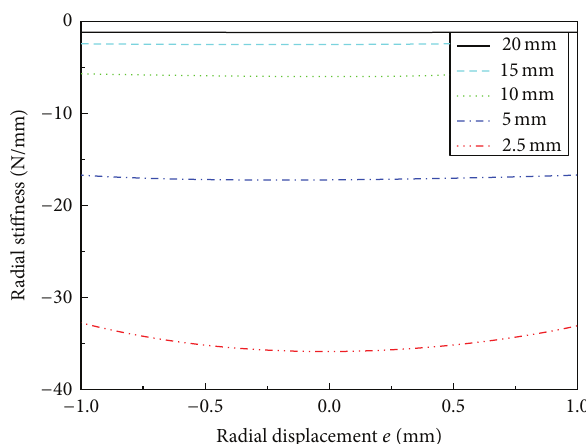
Figure 2: Magnetic force of the negative stiffness structure.